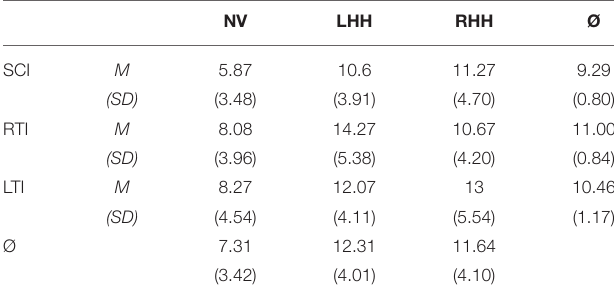
TABLE 9 | Mean and standard deviation of the single-item workload scale per vision condition and intersection type.